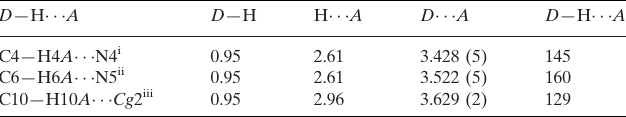
Hydrogen-bond geometry (A˚ , (cid:3)